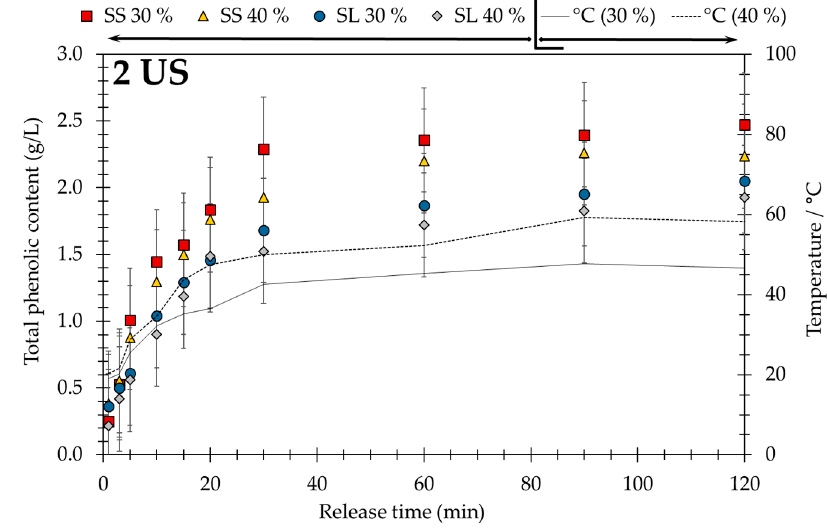
Figure 4. Extraction kinetics (left axis) and measured temperature curves (right axis) using ultrasonics (US).